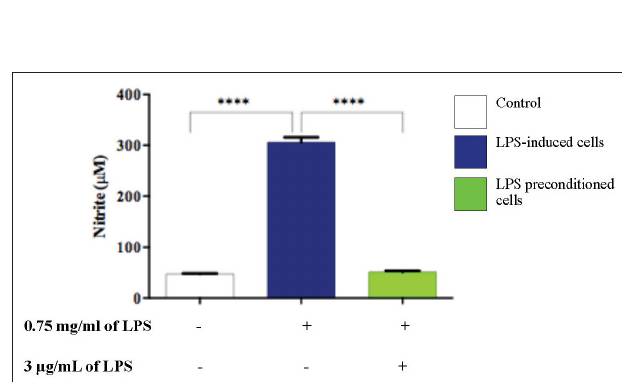
FIGURE 15 | LPS activates pro-inflammatory mediators, ROS. The release of ROS in LPS-induced and LPS-preconditioned cells were measured using DCFH-DA. Bars represent mean data ± S.E.M from three independent experiments. Data were analyzed using one-way ANOVA, followed by a Bonferroni post-hoc test. Relative release of fluorescence intensity in LPS-induced cells were compared to the control. **** p < 0.0001 considered to be statistically significant.